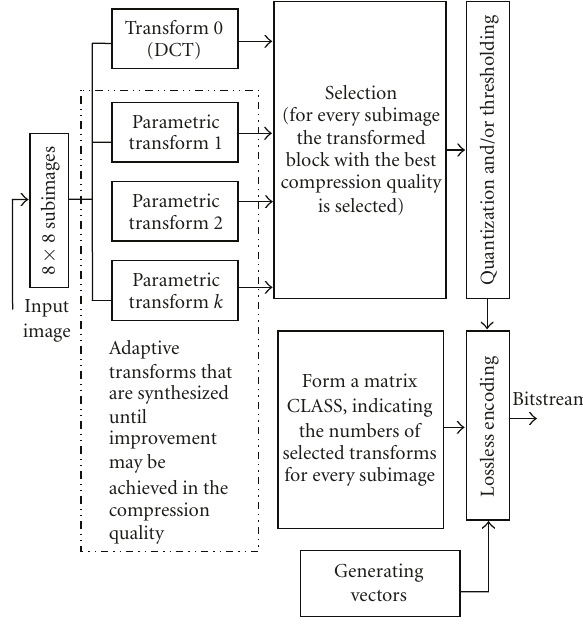
Figure 5: Image coder of proposed compression